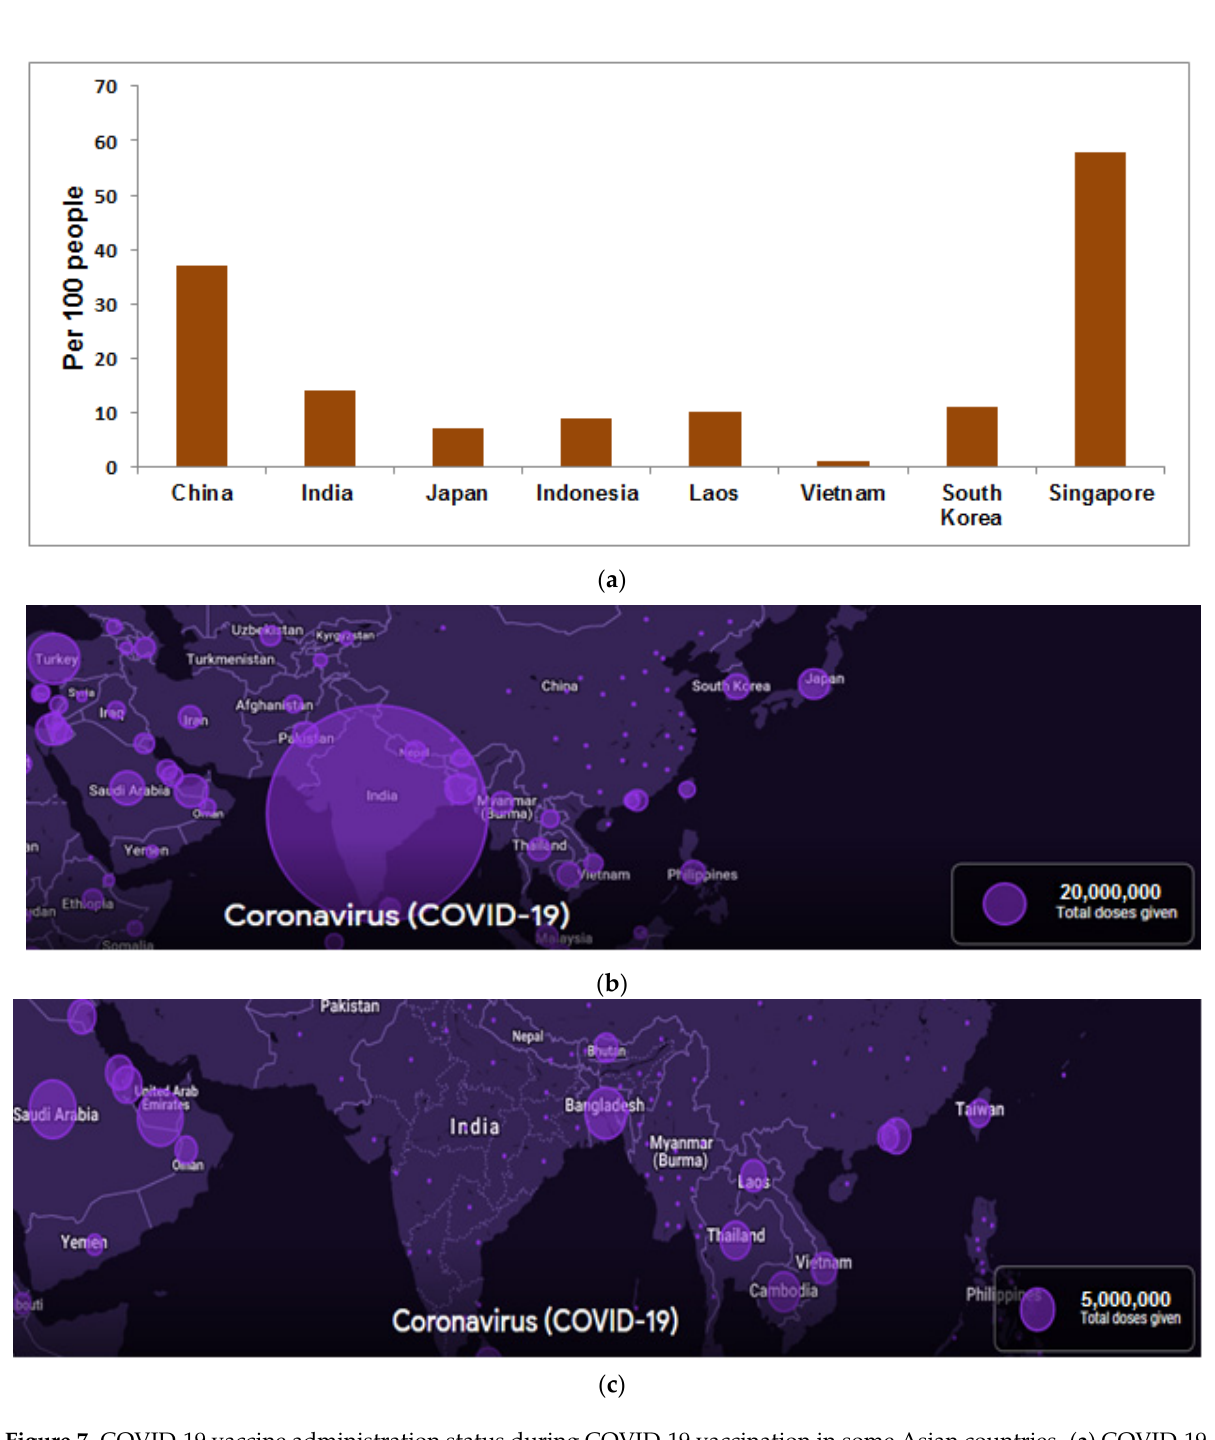
Figure 7. COVID-19 vaccine administration status during COVID-19 vaccination in some Asian countries. ( a ) COVID-19 vaccine administration in some Asian countries (per 100 people in a country’s total population) [41]. ( b ) Asian countries (China and India) which vaccinate the people with more than 20 million vaccine doses) (last 14 days vaccination data from China is not correctly available). ( c ) Asian countries which administrated more than 5 million vaccine doses in the last 14 days to the people (data source: Our World in Data, Google Analytics).